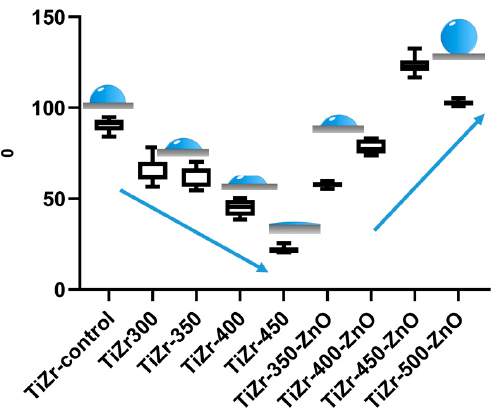
Figure 8. Contact angle distribution of TiZr alloys after treatment in different solution. Blue arrow demonstrates trends in Ca(H 2 PO 2 ) 2 electrolyte bath and with ZnO NPs.